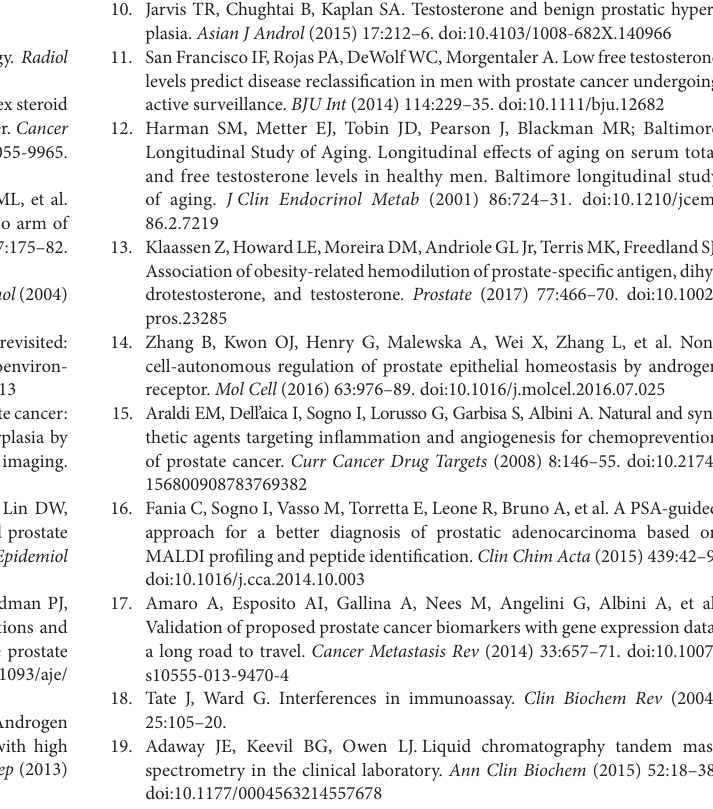
FigUre s2 | Scheme of singular absolute concentration match and the steroids ratio concentration match models. TaBle s1 | The internal standard concentrations. TaBle s2 | The calibrate analyte concentrations and the calculated concentrations of both known and unknown samples. TaBle s3 | Two steroid relationship ratios that can selectively discriminate patients with prostate carcinoma from benign prostate hyperplasia and healthy controls, together with the associated enzyme